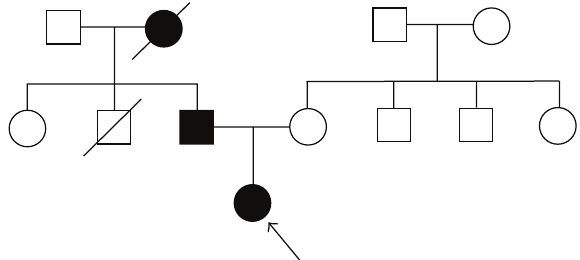
Figure 1: Family pedigree showing that the proband and her father have hypophosphatemic rickets and that the grandmother might have had the same disease. The death of the father’s brother was unrelated to the disease. The remaining family members are